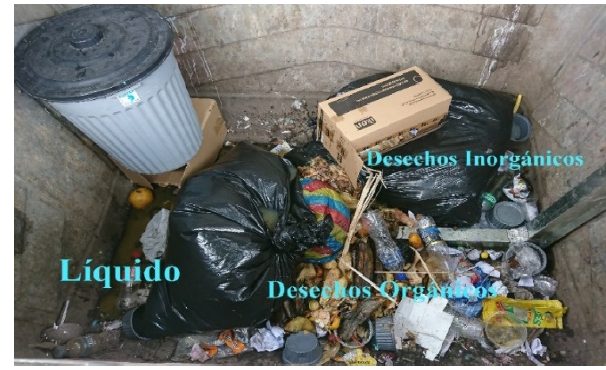
Figure 13. View inside the container.